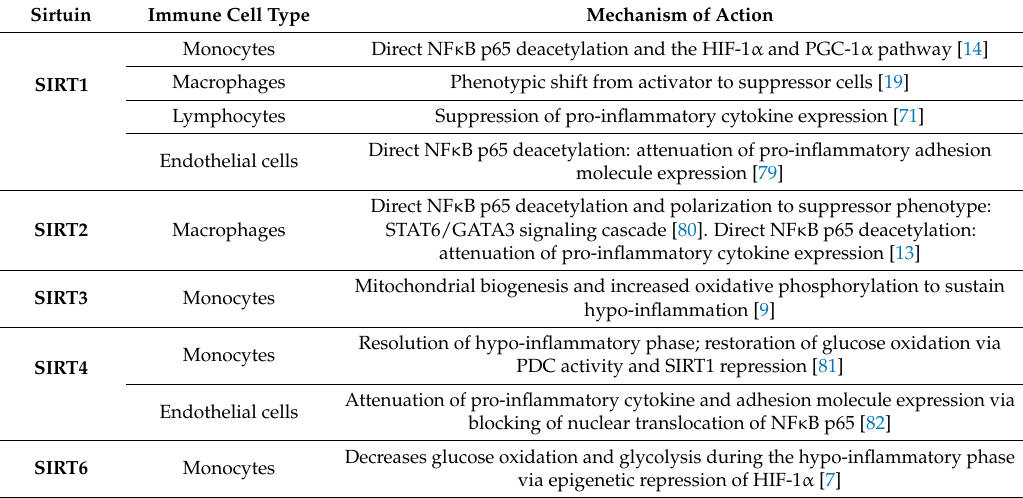
Table 1. The role of different sirtuins in various immune cells during